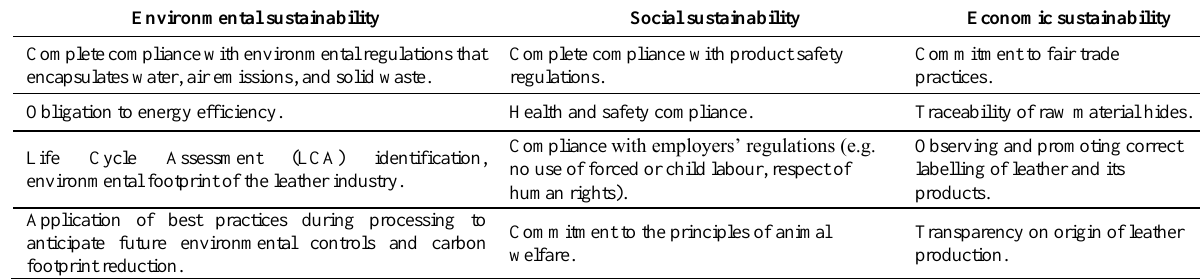
Table 1. Leather Sustainability practices